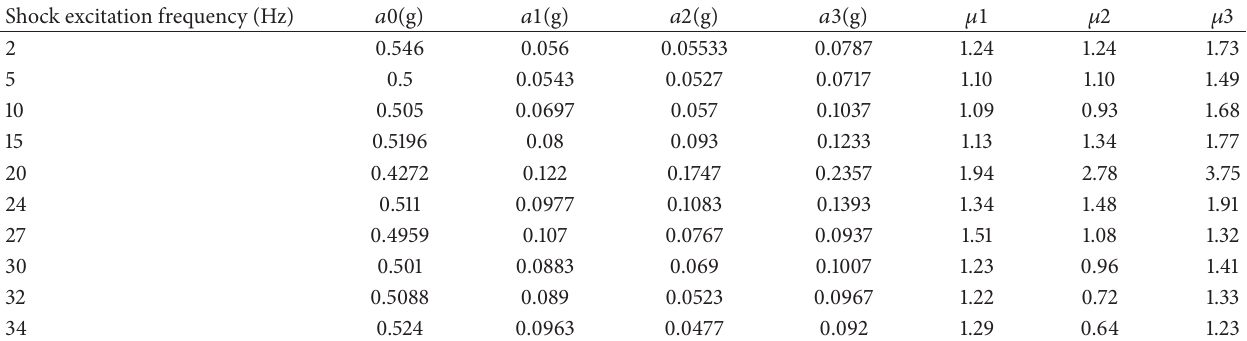
Table 9: Extreme and enhanced coefficient of acceleration response (0.5 g).